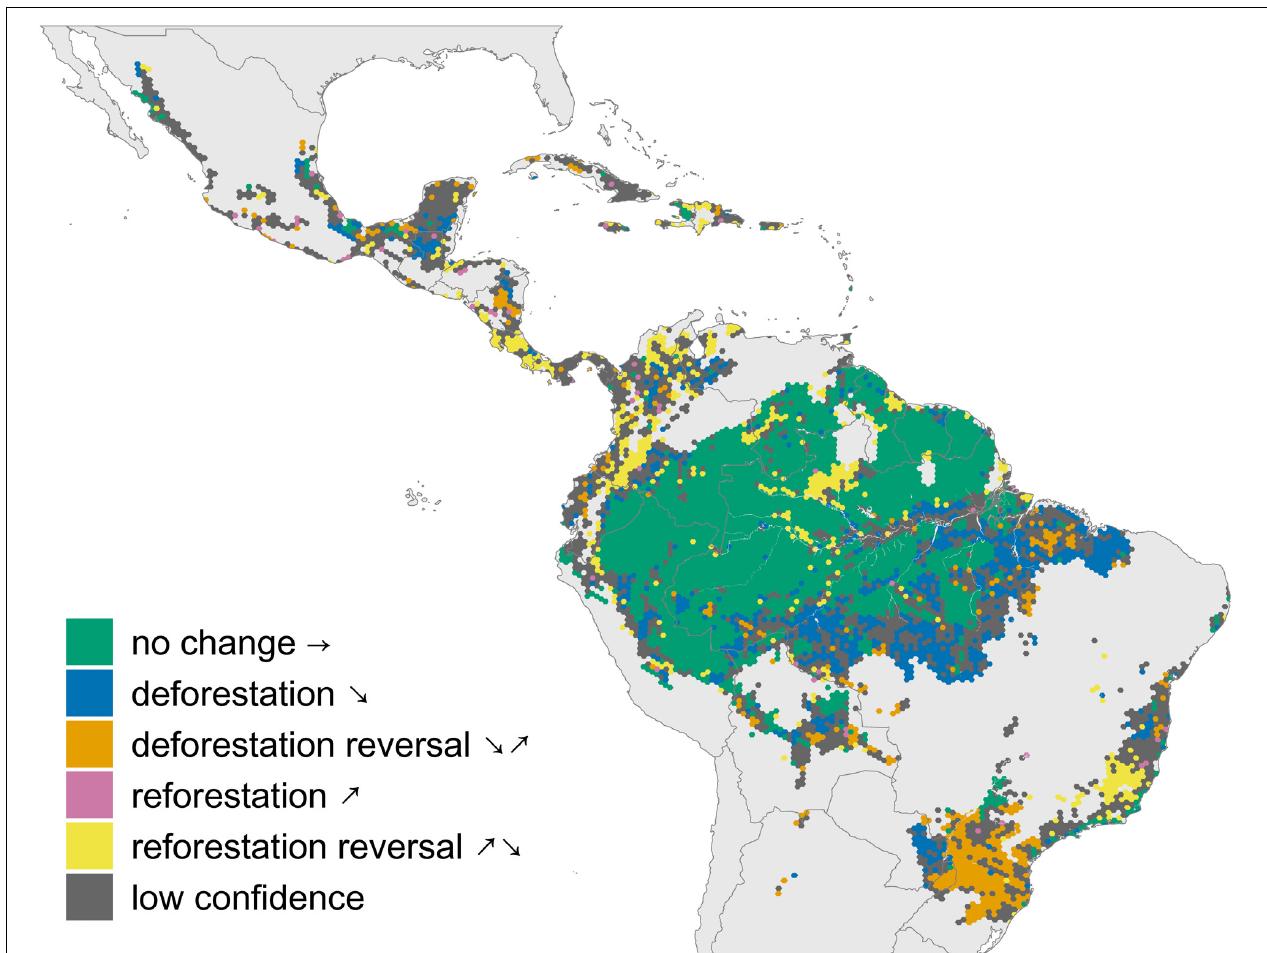
FIGURE 1 | Trajectories of forest change in tropical Latin America and the Caribbean. Light gray areas indicate biomes other than tropical forest. Dark gray areas indicate forested regions where noisy trajectories prevented classification. Arrows in the legend illustrate the shape of the forest cover trajectory change over